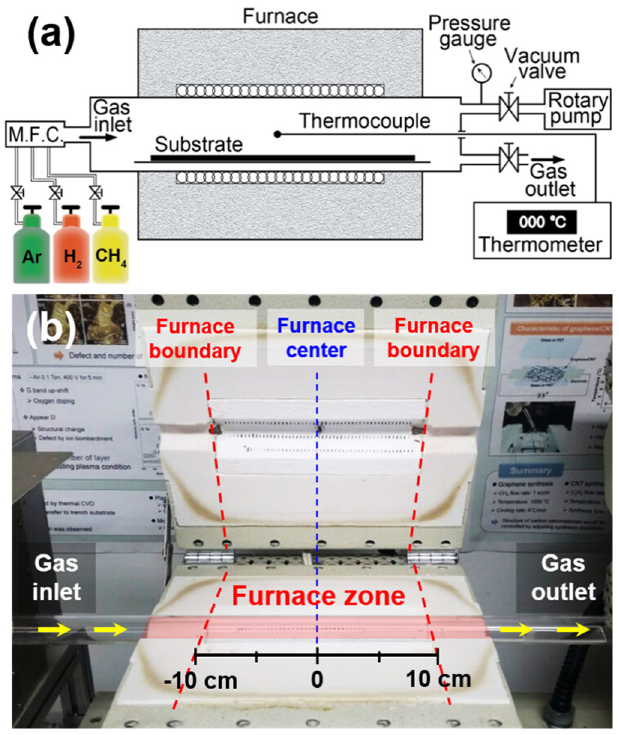
Figure 1. ( a ) Schematic illustration of the CVD chamber. ( b ) Digital photo of the apparatus.